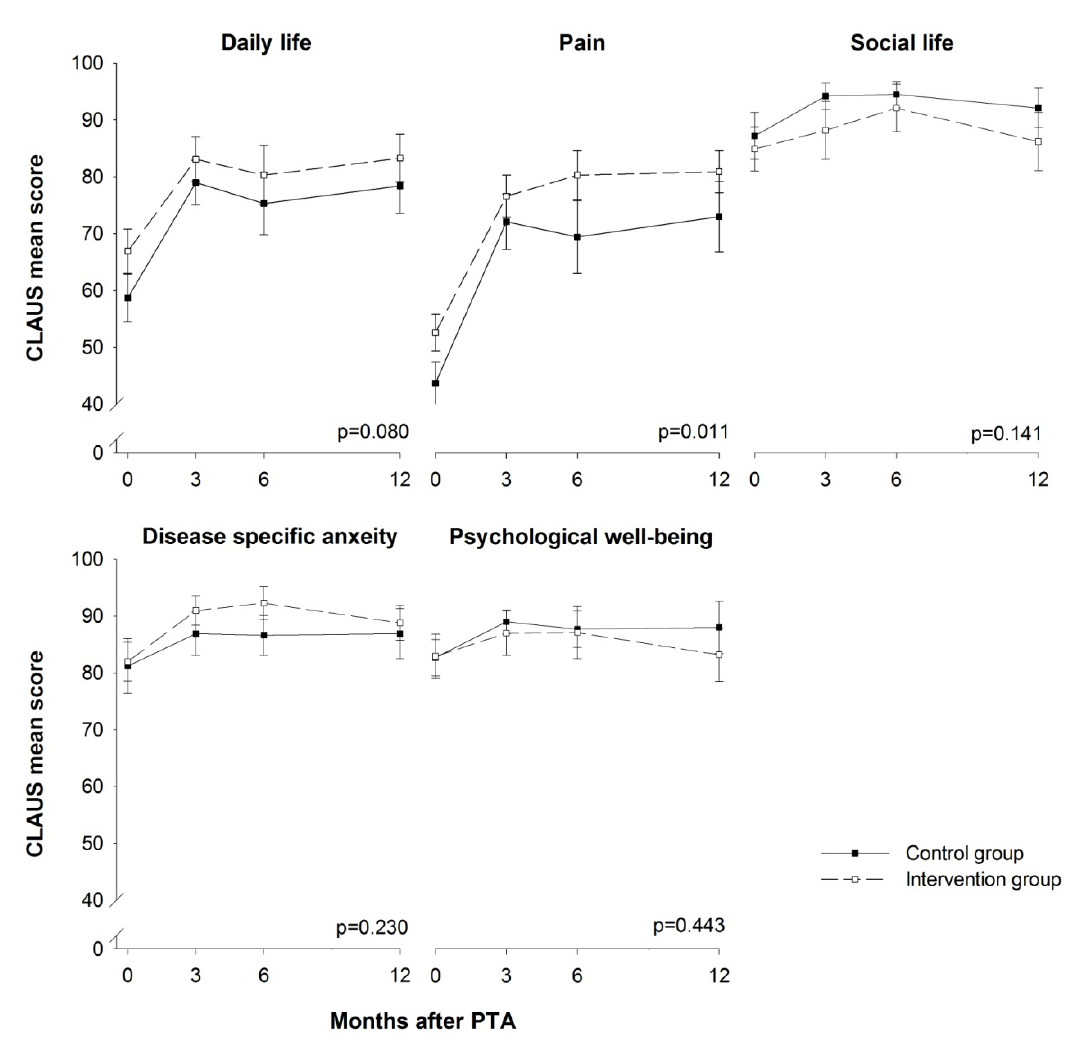
Figure 6. CLAU-S domain scores. A score of 0 represents the worst possible health, and 100 represents the best possible health. CLAU-S = the Claudication Scale. Values are mean, error bars indicate